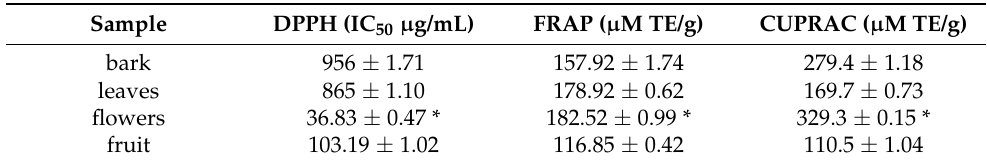
Table 9. Antioxidant activity of S. vulgaris extracts by different assays. Sample